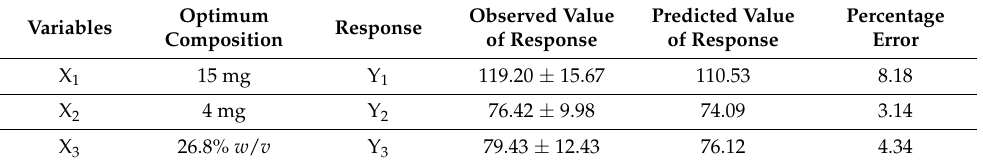
Table 4. Composition, experimental vs. predicted value with percentage error of optimized PLM- loaded glycerosome